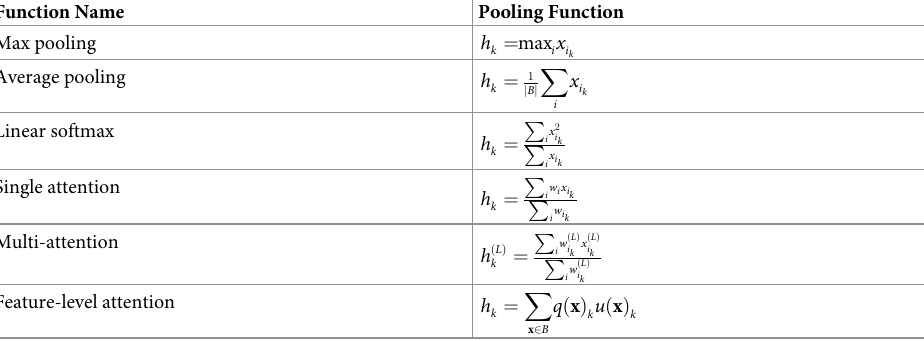
learned weight. The attention module outputs are concatenated before being passed to the output layer. In the feature- level attention equation, q ( � ) is an attention function on a representation of the input features, u ( �